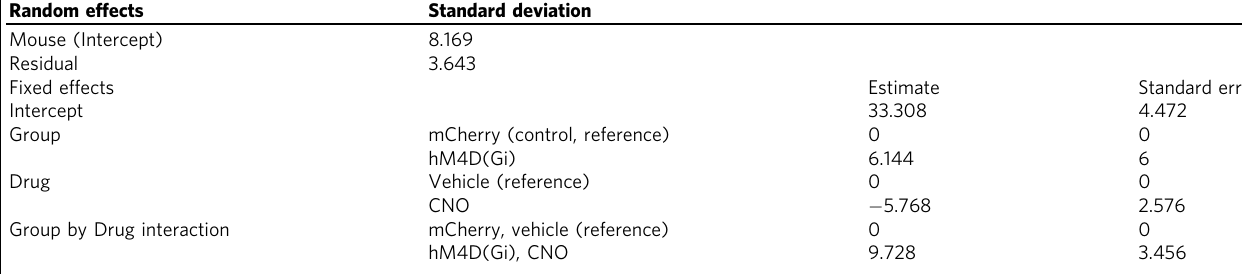
Table 2 LME model: effect of chemogenetic inhibition of VM on NREM sleep duration